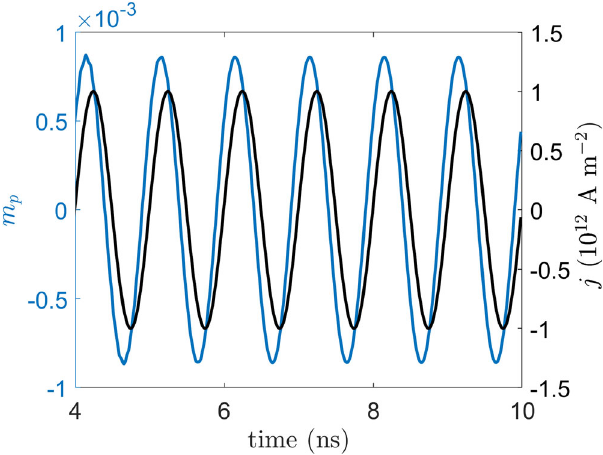
Fig. 4 Averaged magnetization. Spatially averaged magnetization dynamics along the path T ( θ ) from micromagnetic simulations of the ground state subject to a microwave current of 1 GHz and amplitude 10 12 A m − 2 . The magnetization component m p is perpendicular to the path T ( θ ) is shown by a blue curve and the microwave density current j is shown by a black